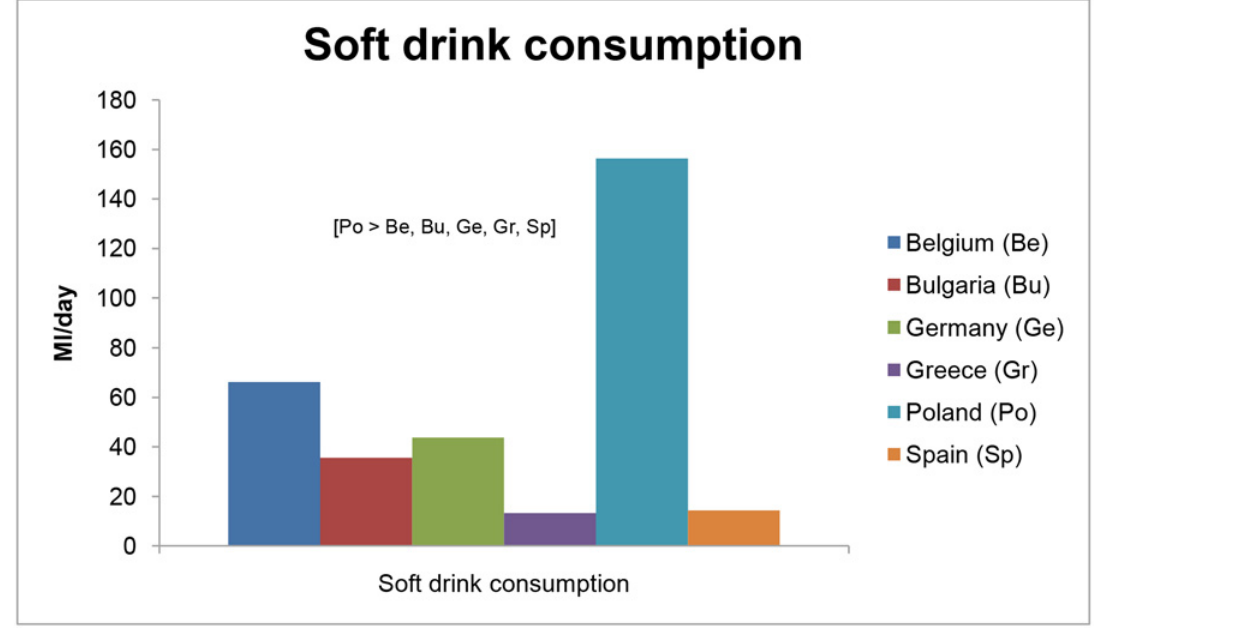
Fig 4. Differences in preschoolers ’ soft drink consumption across